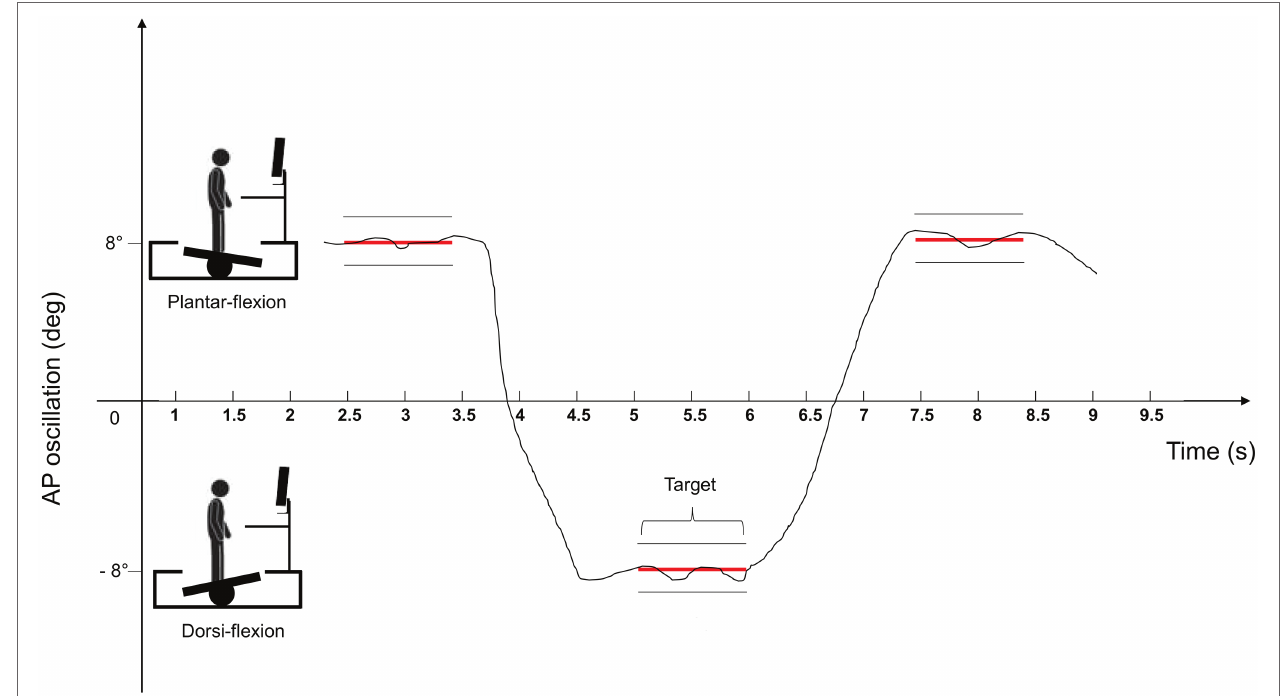
FIGURE 1 | Graphical representation of the feedback given to the subjects during the dynamic postural balance test. The line on the screen represents the track of the angular signal that the subjects had to drive into superior and inferior targets moving the platform anterior-posteriorly through dorsi-flexion and plantar-flexion of the ankles.